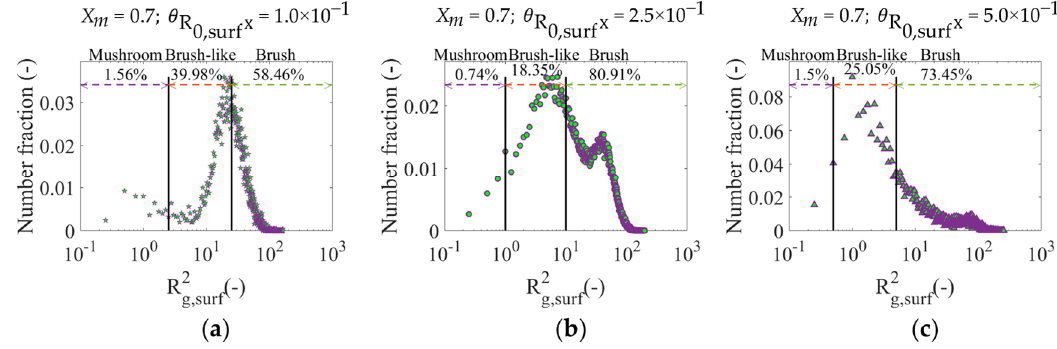
Figure 10. Total distribution of the squared radius of gyration ( R g,surf 2 ) of individual surface-tethered polymer chains (purple-contoured full green symbols) grown on the surface at a monomer conversion X m = 0.7. Three (average) initiator surface coverages are considered: ( a ) 1.0 × 10 - 1 (five-pointed star), ( b ) 2.5 × 10 - 1 (circle), ( c ) 5.0 × 10 - 1 (upward-pointing triangle). The two black vertical lines are calculated from Equations (1) and (3), and these lines are only there for a guide-of-the-eye; arrows denote bimodal character; conditions as in Figure 8; translational mode. Figure S6 in Supporting Information: evolution of the conformational regimes of the surface-tethered polymer chains as a function of monomer conversion.